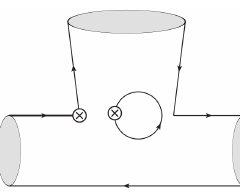
Figure 13 . Topological diagram ⇒ Topological-scattering diagram ⇒ Triangle diagram in C ⇒ A transition.